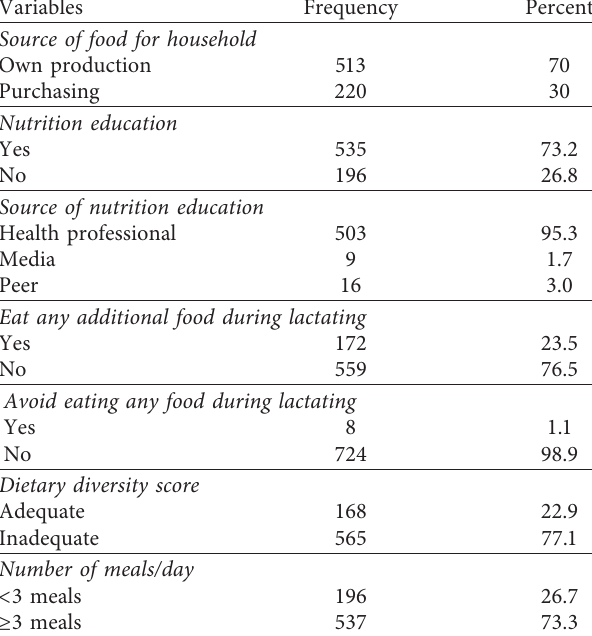
Table 3: Health information and feeding practice of study par- ticipants among lactating women who had children aged 6 to 23 months in Dega Damot Woreda, Northwest, Ethiopia, March-April 2018 ( n � 733).